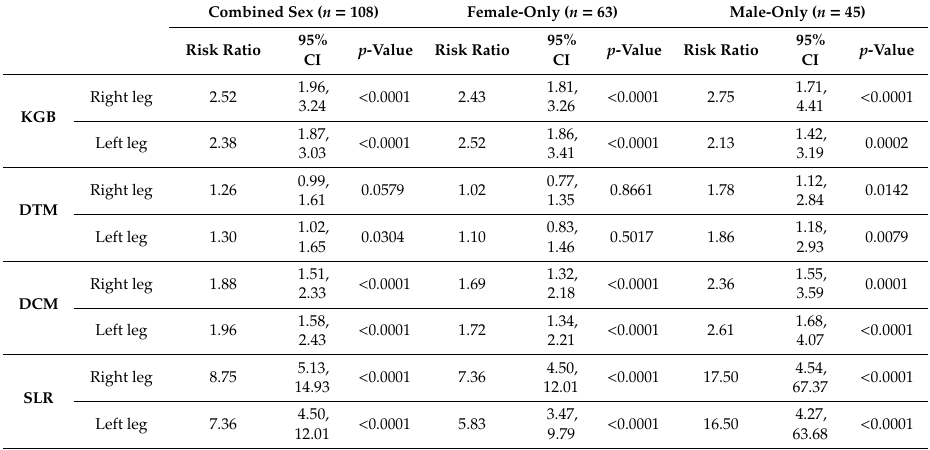
Table 6. Analysis of risk ratios of anatomical parameters for combined-sex, female only, and male